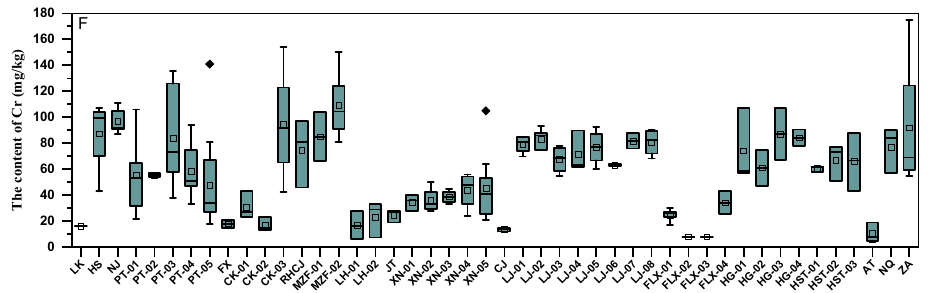
Figure 2. pH value ( A ) and heavy metal content of Pb ( B ), Cd ( C ), As ( D ), Hg ( E ), and Cr ( F ) from different bamboo shoot areas.